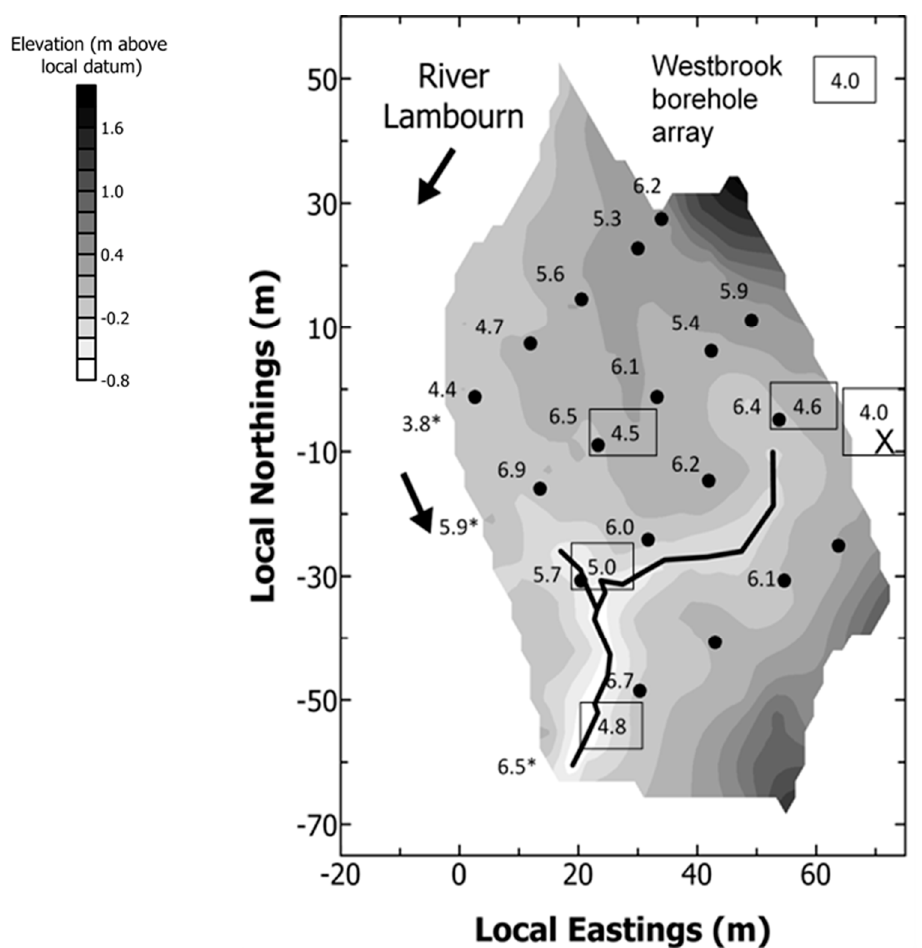
Figure 10. δ 15 N values in the Boxford wetland. Data in boxes refer to δ 15 N of nitrate in boreholes, piezometers and the proto-stream. Data without boxes refer to average δ 15 N of the top 4–5 leaves of three individual Phalaris arundinacea plants. Numbers next to closed circles are for samples collected close to ceramic cup samplers; numbers marked with an asterisk* are for plants sampled from the river bank.